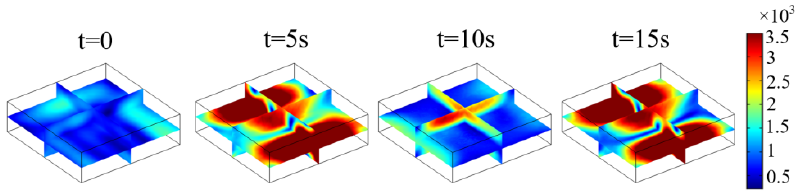
Figure 14. Electric field distribution of potato at different motion moments (Cavity height: 160 mm, unit: V/m).